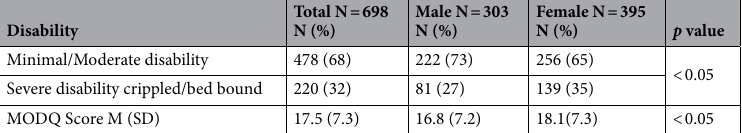
Table 2. Functional disability (N = 698). N: Number of Subjects; %: